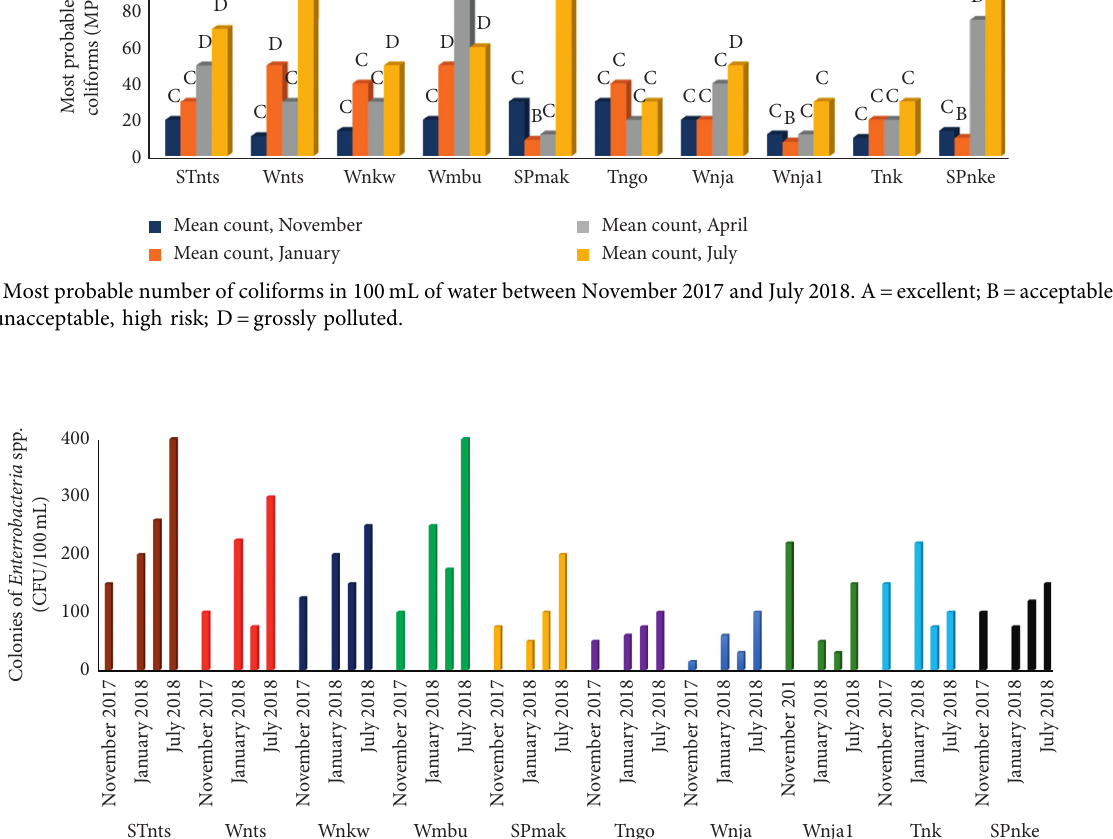
Figure 3: Colonies of Enterobacteria spp. isolated in the sampled waters between November 2017 and July 2018.